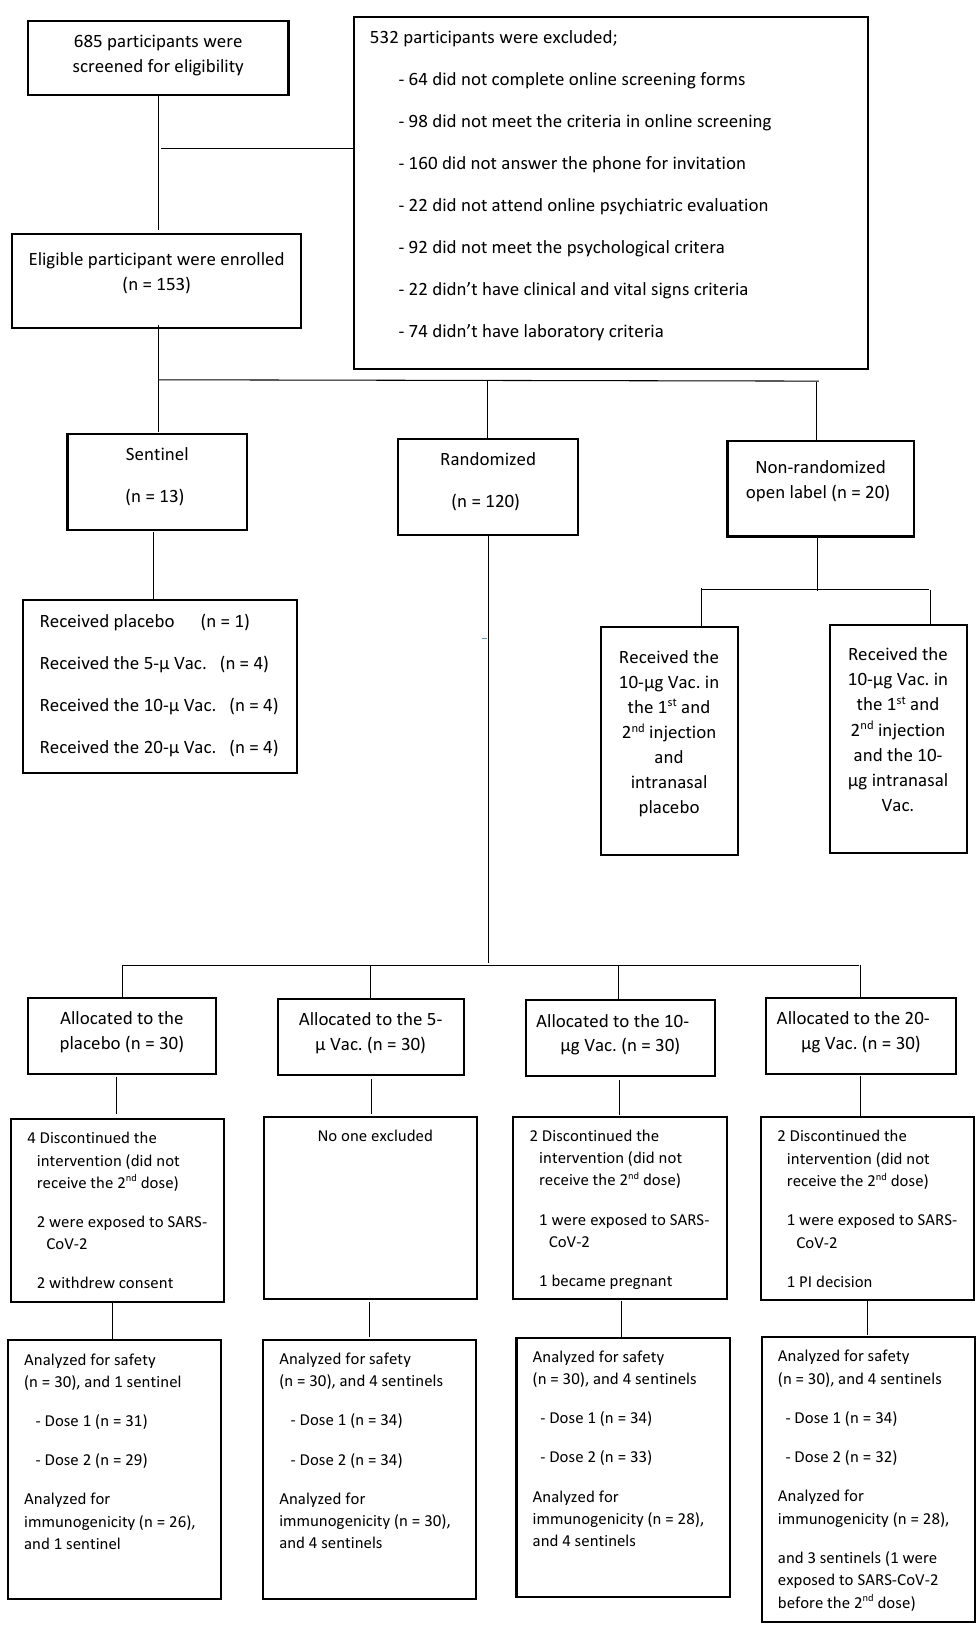
Figure 1. Participant flow